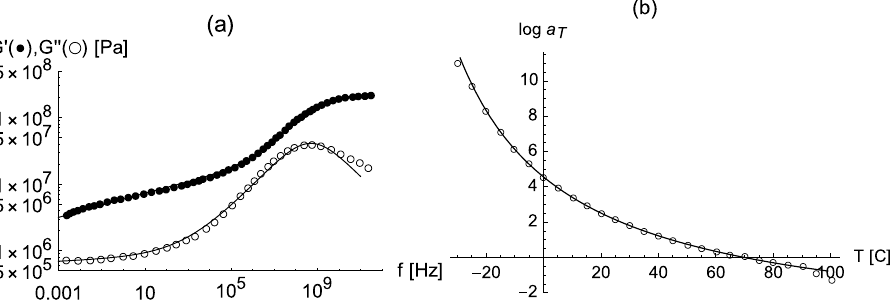
Figure 1. ( a ) Shear storage modulus G ′ = E ′ / 3 (solid circles) and shear loss modulus G ′′ = E ′′ / 3 (open circles) vs. frequency f . The symbols are taken from the respective master curves in Fig. 8d of Ref. 25 obtained at a reference temperature of 70 °C and with a shear strain amplitude of 0.2% . The solid lines are drawn using Eq. (16) with E ′ 1 = 600 MPa, x ′ 1 = 0.25 , E ′ 2 = 150 MPa, x ′ 2 = 0.05 and E ′′ 1 = 240 MPa, x ′′ 1 = 0.35 , E ′′ 2 = 5.1 MPa, = 0.025 and t g = 2 · 10 − 9 s. ( b ) log a T vs. temperature T . The symbols are taken from Fig. 7 of Ref. 25 . Here x ′′ 10 2 the solid line is a WLF fit with c 1 = − 4.41 , c 2 = 137, 64 o C and T ref = 70 o C.